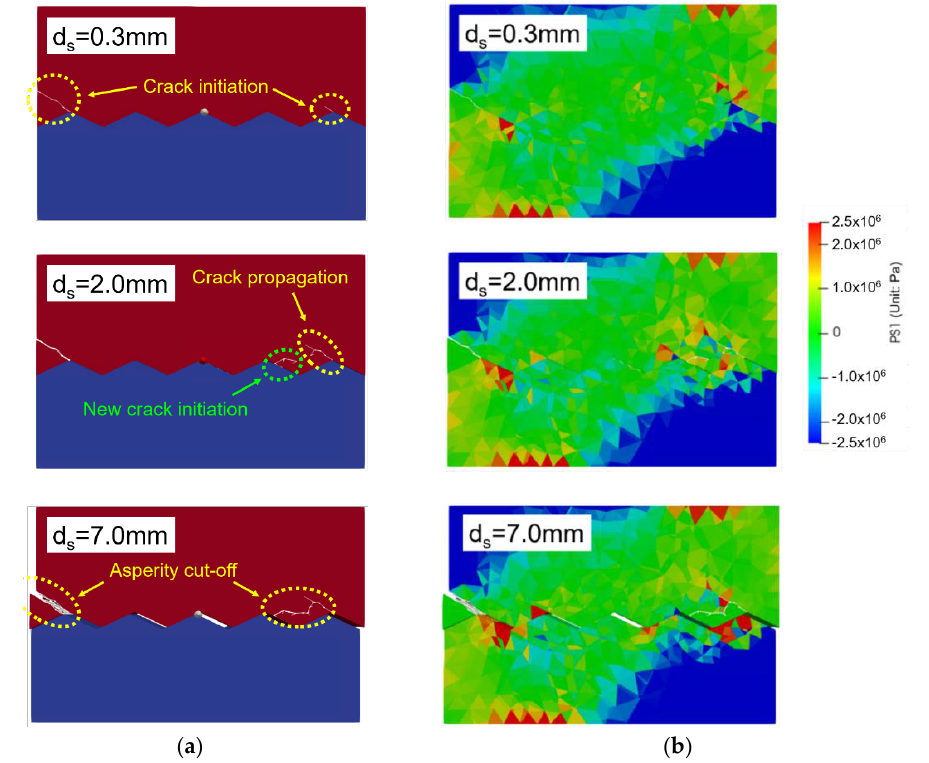
Figure 14. Simulation results in the shear test with a relatively smooth concrete–rock joint for the cases of asperity angles α = 25 degrees. ( a ) Macroscopic crack, ( b ) maximum principal stress distribution (PS1).